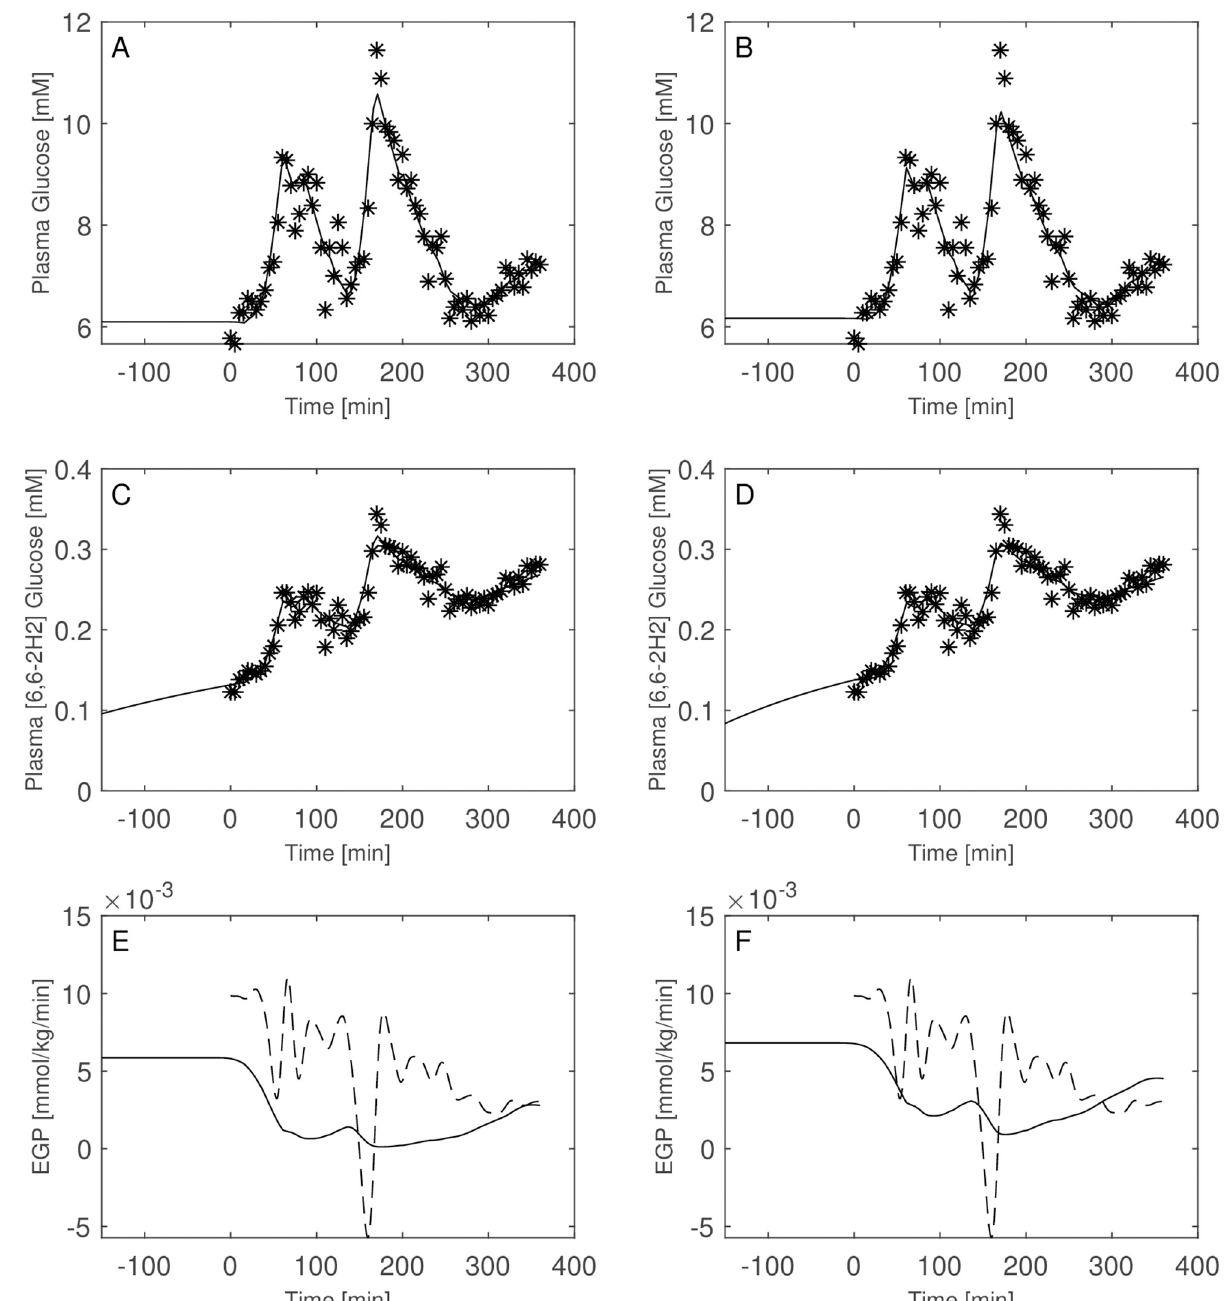
Fig 11. Model comparison for Subject 3. Observed (asterisks) and predicted (line) variables over time with glucose two-compartment model (Panels A, C, E) and one-compartments-glucose model (Panels B, D, F). Dashed line is the predicted EGP with the Steele model. All the observed points refer to data measured on day 2. Plasma glucose concentrations (panel A) are derived from the glucose intra-venous infusion to match plasma glucose observations from the OGTTs of day 1.